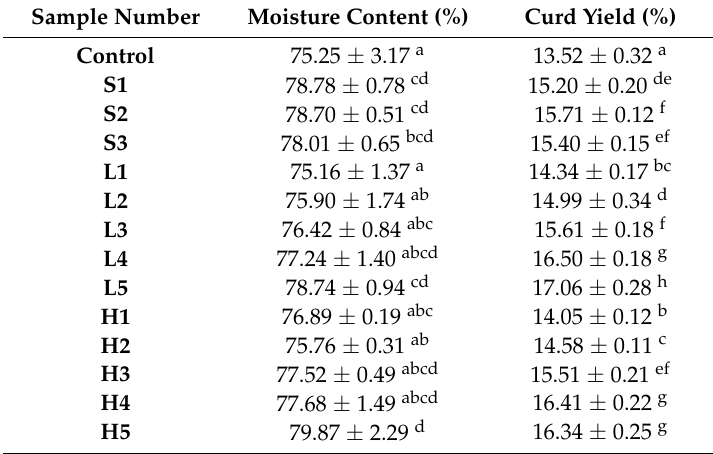
Table 2. The moisture content and curd yield of rennet induced